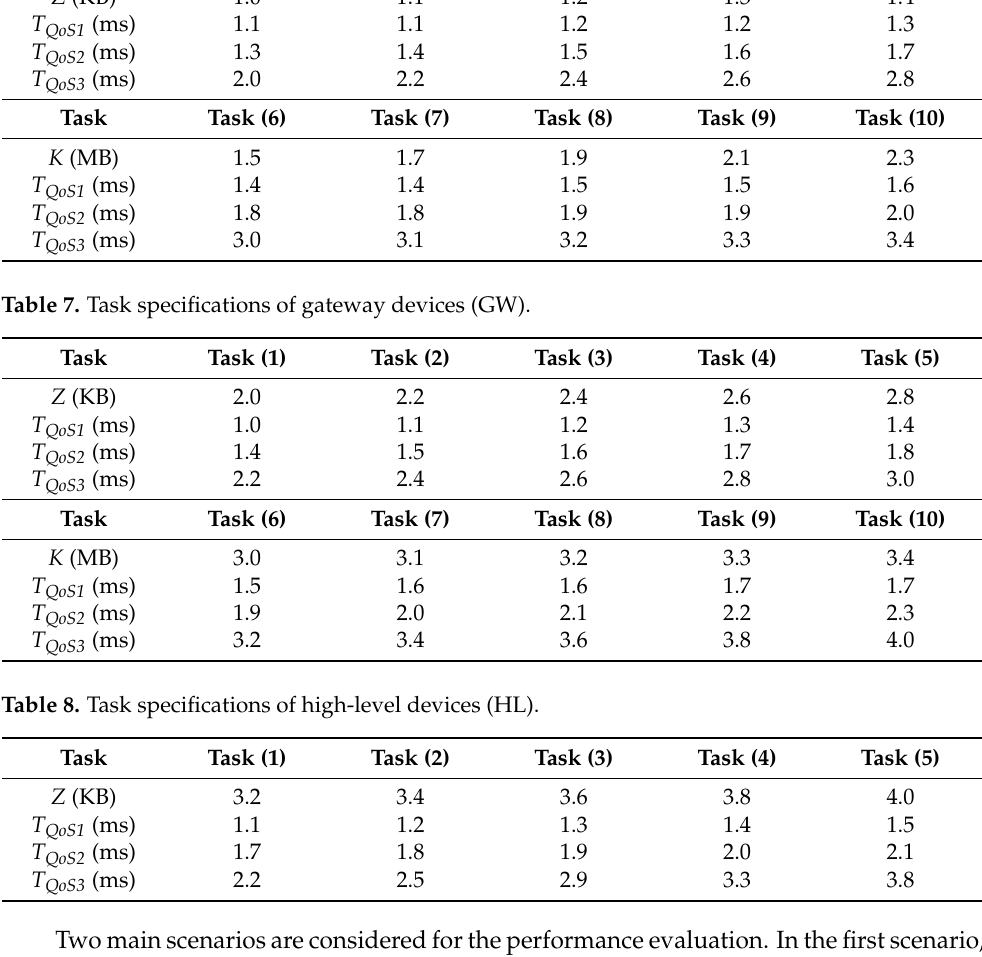
Table 6. Task specifications of low-level devices (LL).